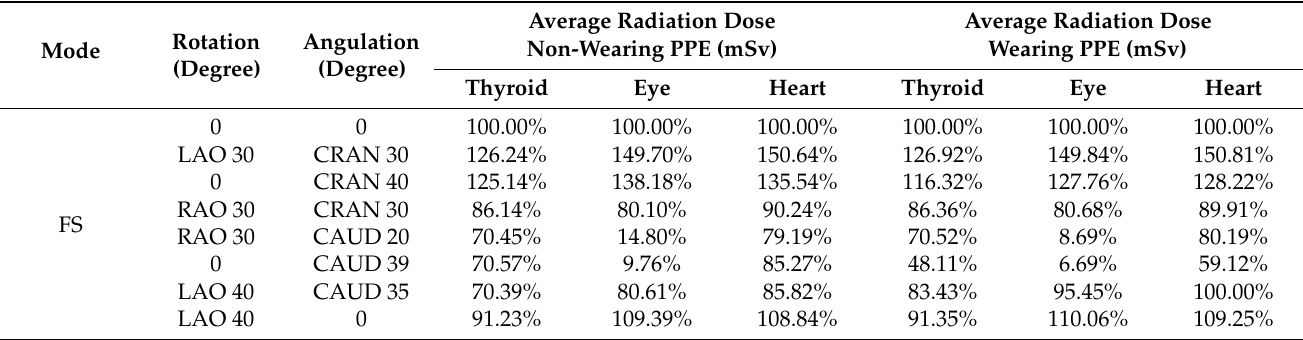
Table 4. The simulated occupational organ dose ratio according to rotation and angulation degree of the X-ray tube (zero-degree angle reference) with and without PPE